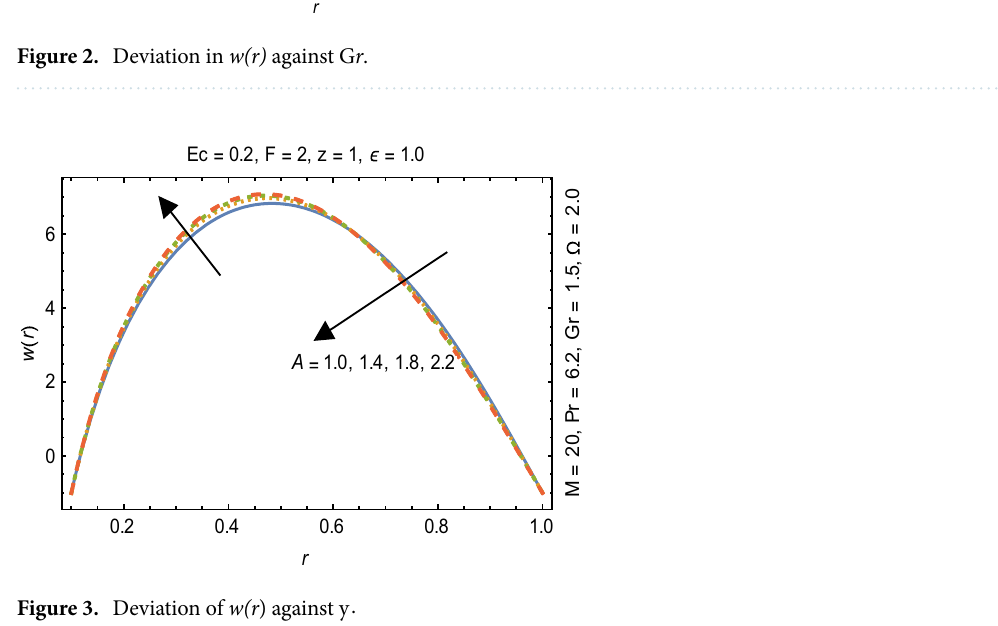
Figure 3. Deviation of w(r ) against y .